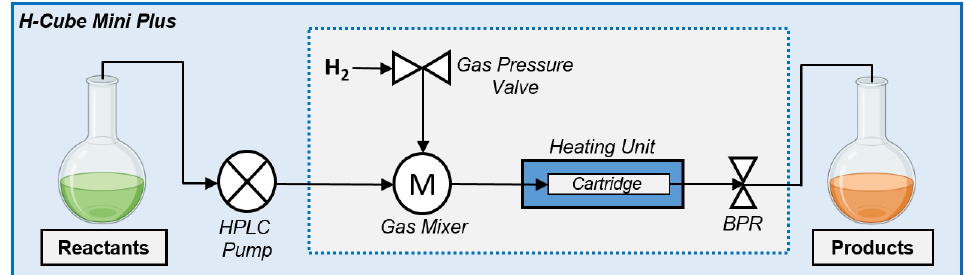
Figure 5. Schematic diagram of the H-Cube ® Mini Plus system.